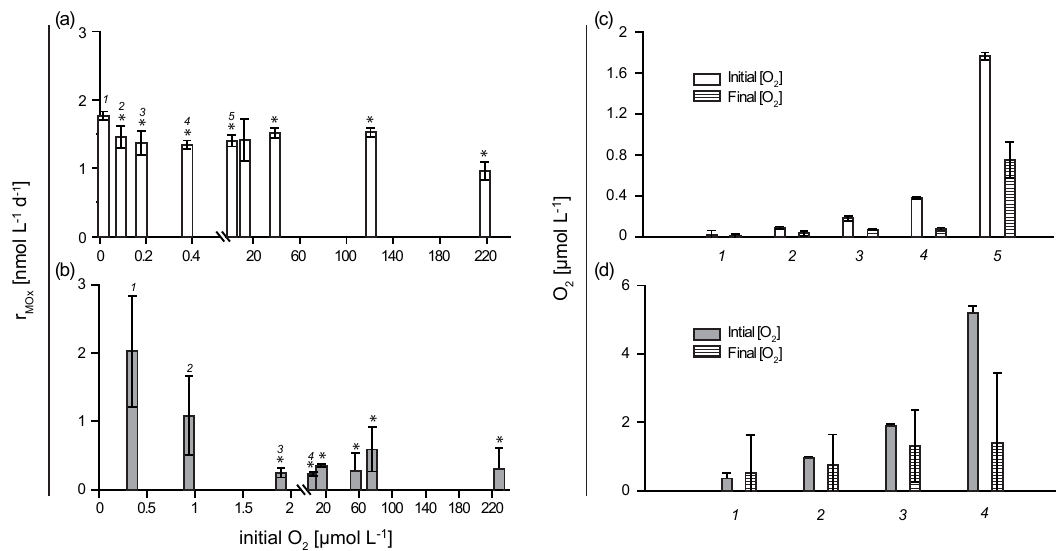
Figure 3. MOx rates in incubations with adjusted oxygen concentrations. r MOx determined in incubations of Boknis Eck water (20mb.s.l.) with 3 H-CH 4 in February 2014 (a) and June 2014 (b) . Asterisks indicate a p <0.05 of a two-tailed, two-sample t test assuming equal variance of the MOx rate compared to the MOx rate of the lowest oxygen concentration. Corresponding oxygen concentrations determined at the beginning and the end of incubations from the February 2014 (c) and the June 2014 sampling (d) for incubations with oxygen concentration <10µmolL − 1 . Numbers on the x axis of (c) and (d) correspond to numbers above the bars in (a) and (b) and indicate the incubation number. Incubations were performed in triplicates and standard deviations are indicated. For oxygen concentrations >10µmolL − 1 , oxygen concentrations at the end of incubations were 14–40% (February 2014) and 3–8% (June 14) lower than at the beginning (data not